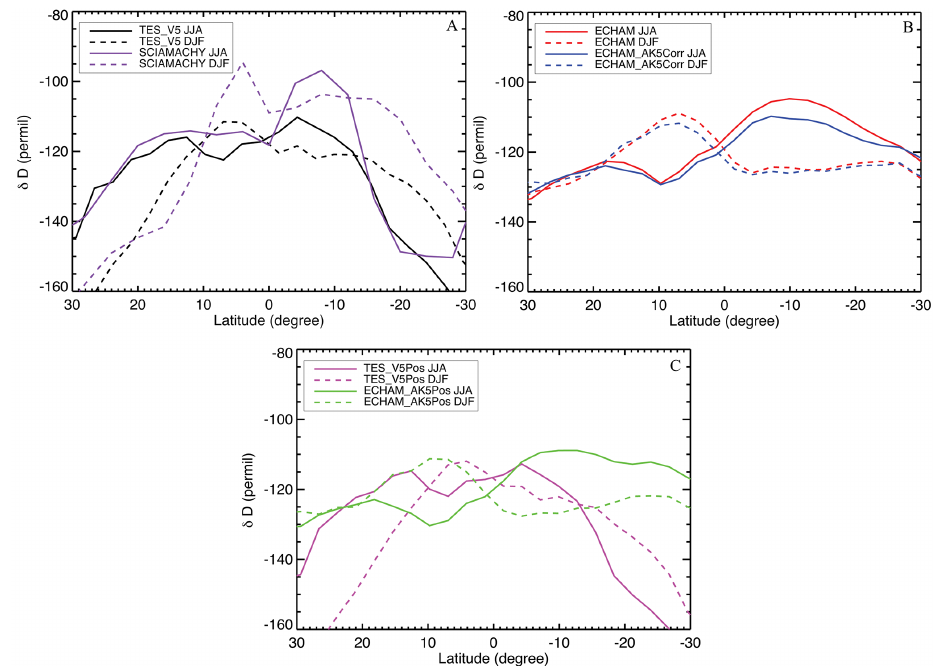
Figure 5. Latitudinal δ D profiles between 30 ◦ N and 30 ◦ S in northern summer (JJA, solid lines) and northern winter (DJF, dashed lines) of TES V5 and SCIAMACHY (a) ; ECHAM and ECHAM AK5Corr (b) ; and TES V5Pos and ECHAM AK5Pos (c) . All figures are weighted averaged between 900 and 425hPa.